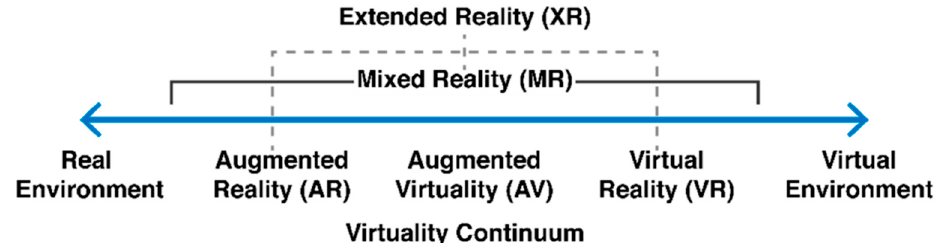
Figure 2. Adaptation of the Milgram and Kishino virtuality continuum.